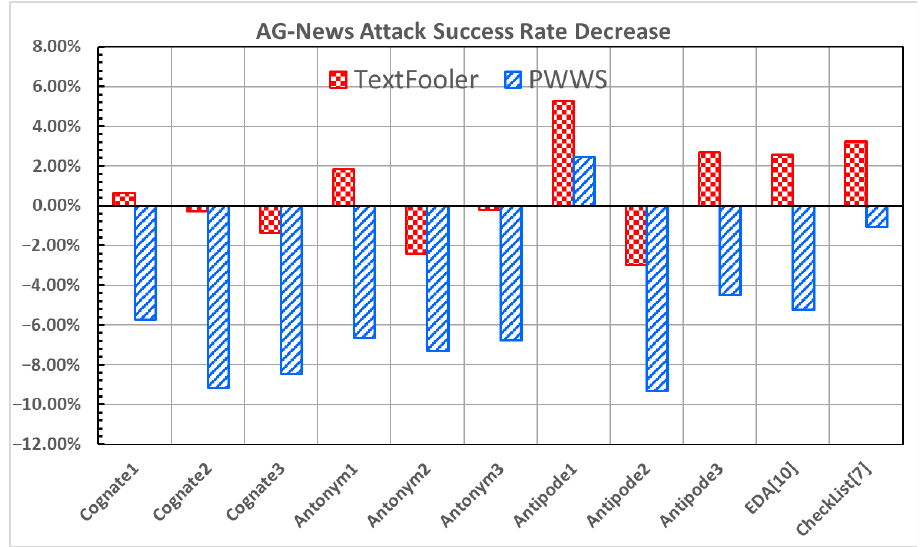
Figure 6. AG-News Attack Success Rate Decrease.